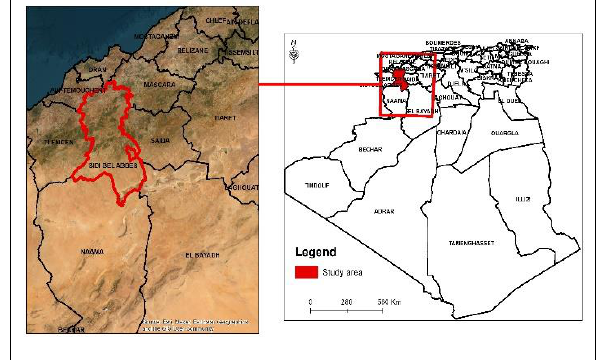
Figure 1 . geographic extent of the study area.